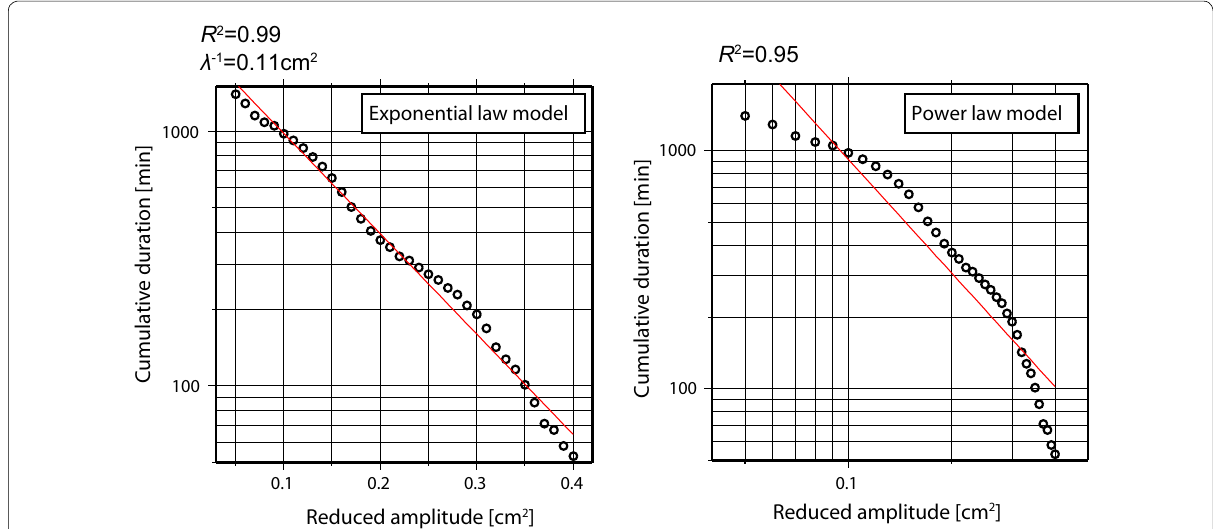
Fig. 10 An exponential model and a power scaling model for the duration-amplitude distribution of the volcanic tremor. The red lines in the diagrams are the least-squares fit of the exponential and power law models. R 2 is the correlation coefficient of the linear regression for both models, and λ − 1 is the characteristic amplitude of the